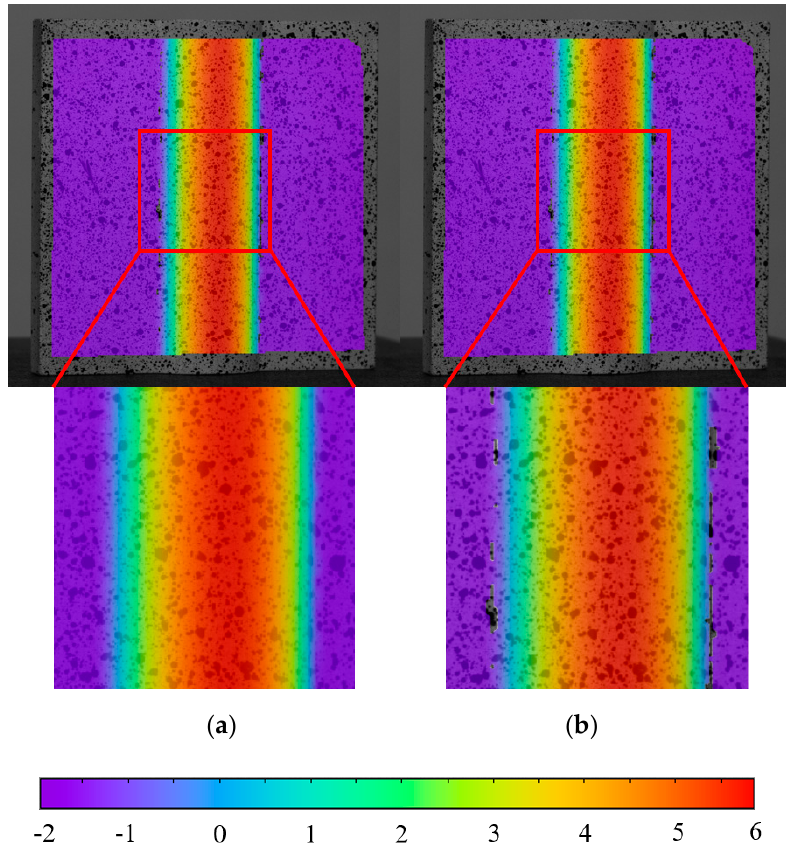
Figure 9. Cloud map of the measured contour/mm. ( a ), morphology result calculated under three perspectives; ( b ), morphology result calculated under two perspectives (green channel was not included).